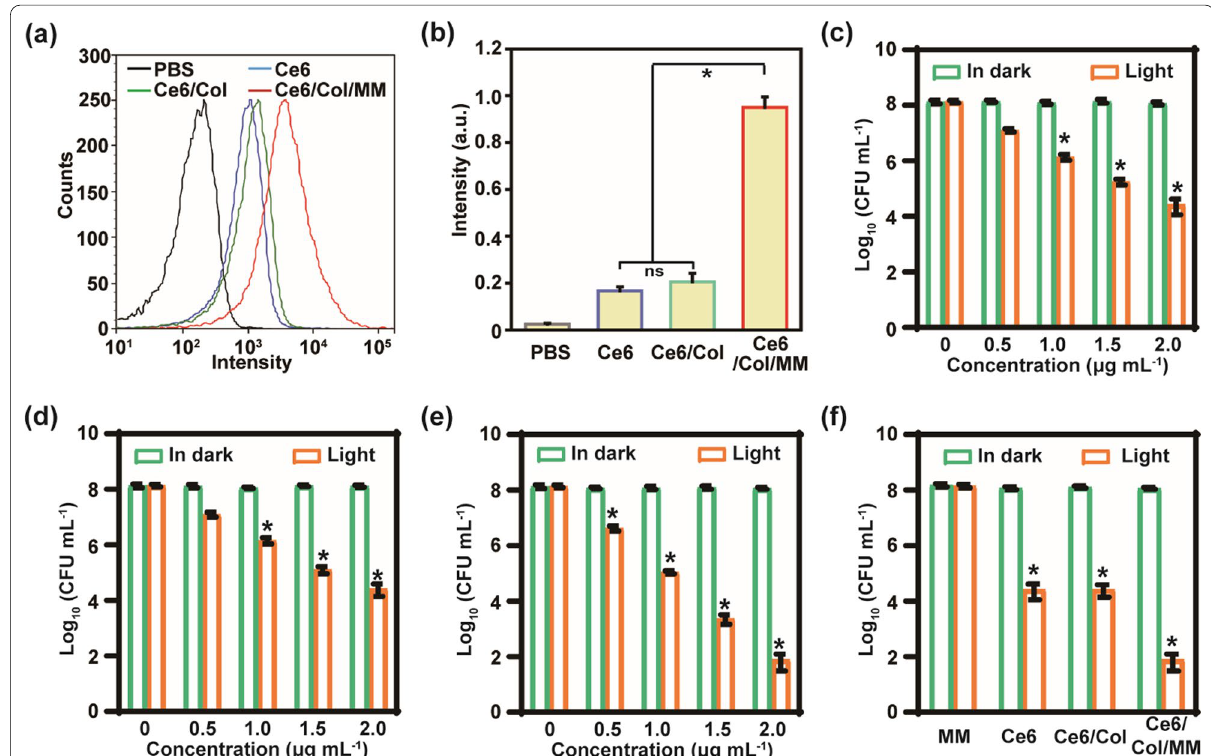
Fig. 3 In vitro enhanced antibacterial activity of Ce6/Col/MM. a Flow cytometry analysis of MRSA subjected to Ce6, Ce6/Col or Ce6/Col/MM (10 μg mL − 1 ) treatment for 1 h. b quantitative analysis of fluorescence intensity based on ( a ). Log value of survived MRSA treated with free Ce6 ( c ), Ce6/Col ( d ) or Ce6/Col/MM ( e ) at serial concentrations and irradiated with 660 nm light (100 mW cm − 2 , 3 min), compared among groups ( f ) at 2.0 μg mL − 1 of Ce6. Data are shown as means S.D. (n 3). * p < 0.005 ± ≥